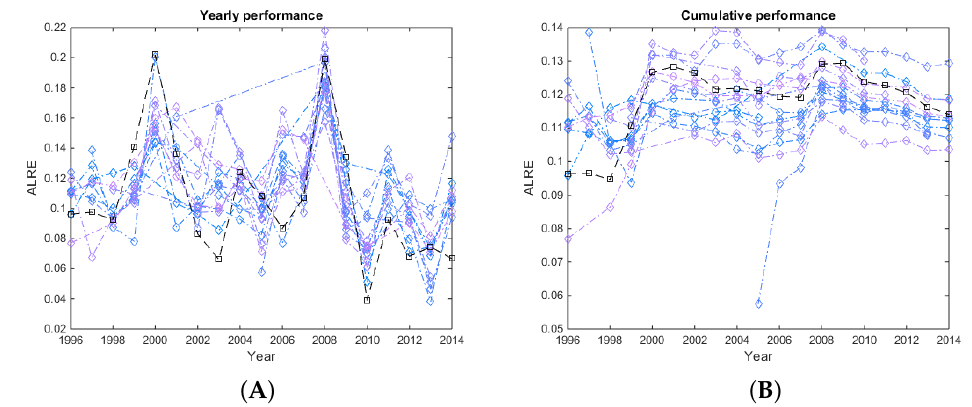
Figure 3. The average ALRE scores over all questions, for each year between 1996 and 2016, for all experts who answered at least one question per year for 10 years, shown as ( A ) yearly performance, and ( B ) as cumulative performance. Each line corresponds to a single expert, with the black line corresponding to the Australian Treasury forecasts.